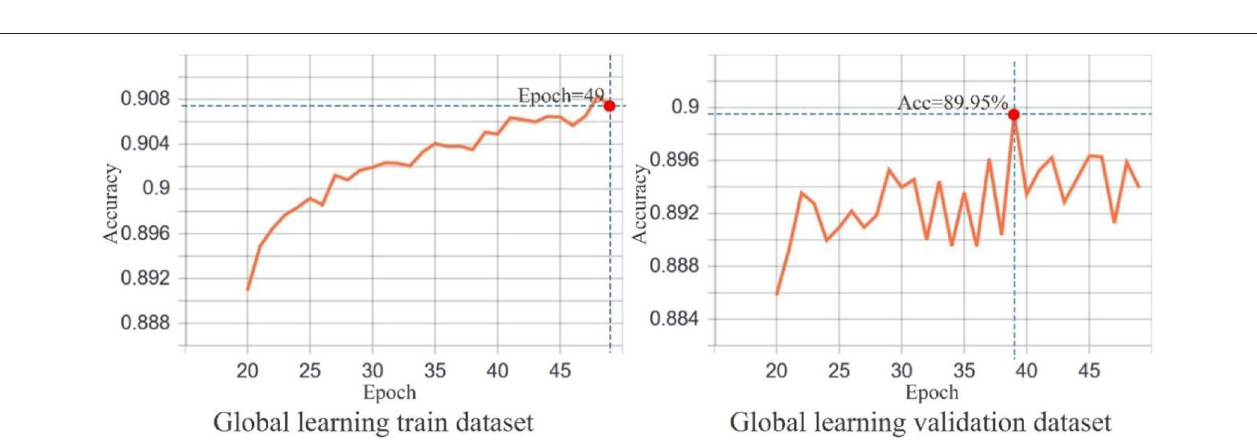
FIGURE 6 | Transfer learning training accuracy. The number of epochs was set at 20. The graph on the left presents early stopping at epoch 12. The graph on the right shows a maximum accuracy of 77.2%.